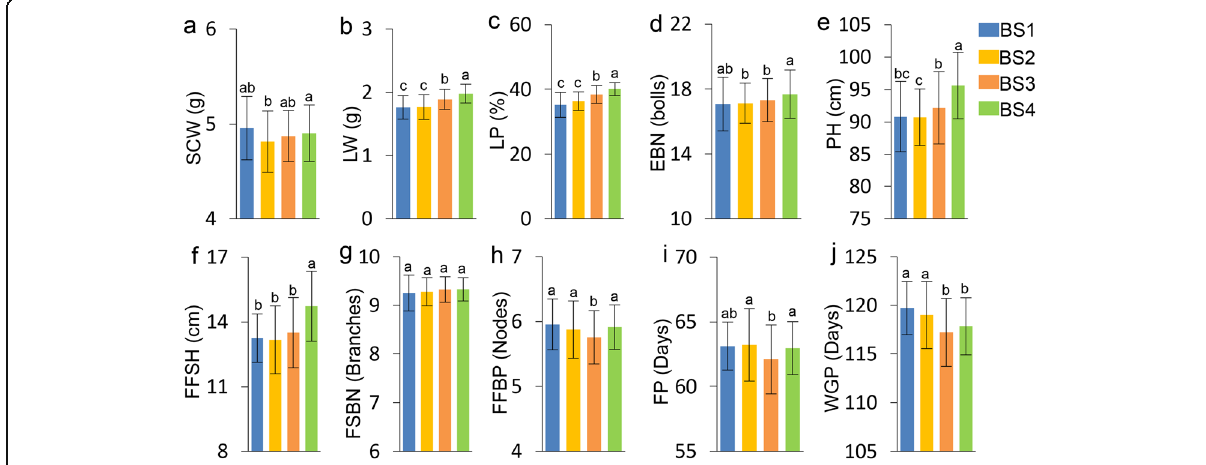
Fig. 4 The statistic analysis and comparison of the ten cotton yield-related traits in the four breeding